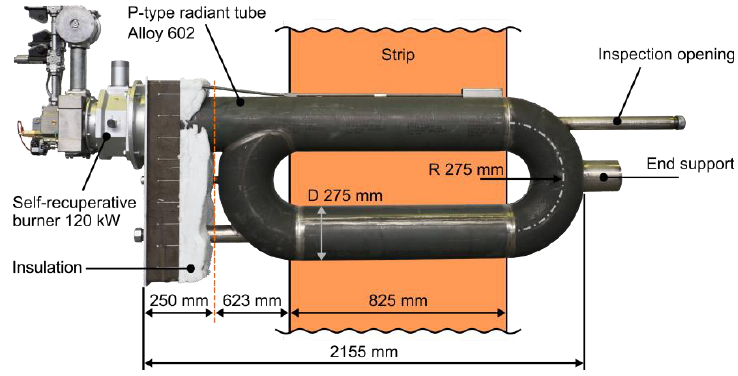
Figure 6. P-type radiant tube used for this investigation.